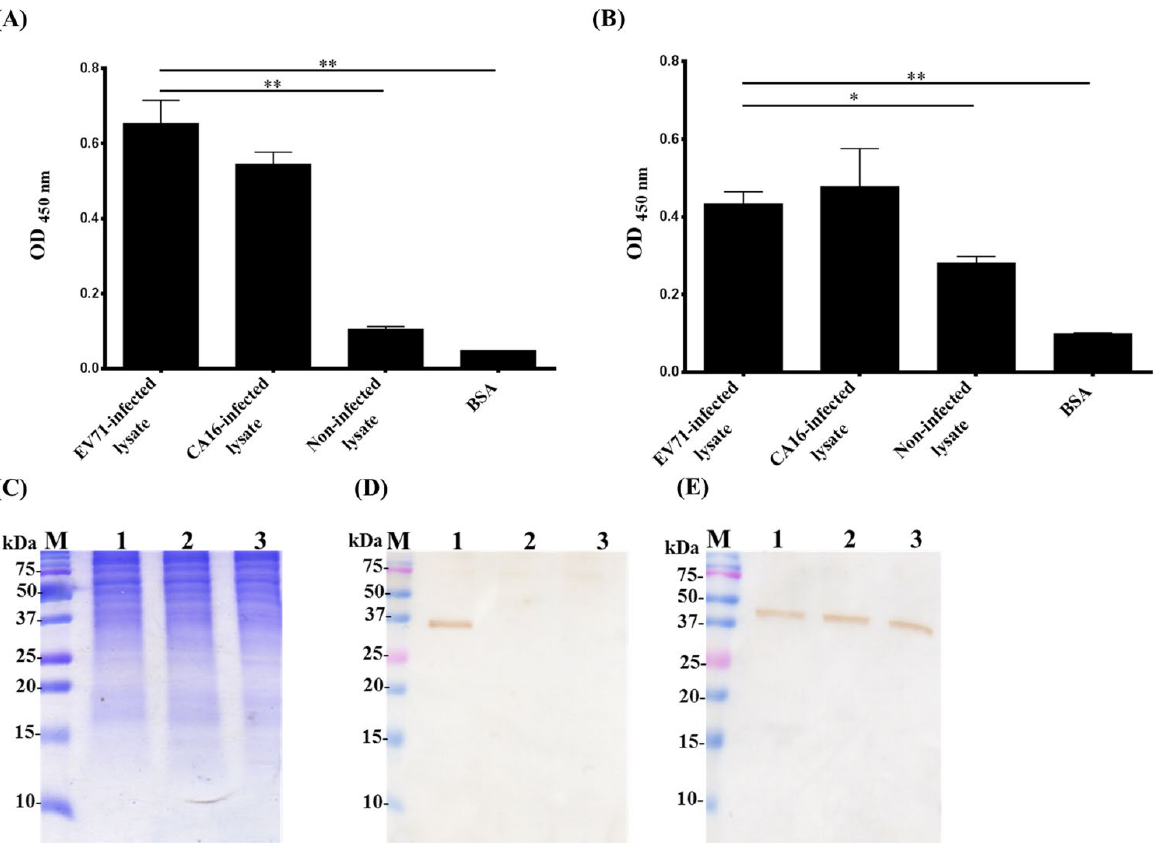
Figure 5. Cross-reactive analysis of IgY and EV71S1 antibodies against Enteroviruses 71. The EV71- infected, CA16-infected, non-infected cell lysates and BSA were coated on ELISA wells, respectively. The purified ( A ) IgY and ( B ) EV71S1 scFv antibodies were used for probing the viral proteins in lysates. *: p < 0.05. **: p < 0.01. ( C ) After SDS-PAGE separation, the PVDF membranes immobilized with EV71-infected (lane 1), CA16-infected (lane 2), and non-infected cell lysates (lane 3) were detected by purified ( D ) IgY and ( E ) EV71S1 scFv antibodies. ELISA experiments were run in a duplicated manner and statistically analyzed as mean ±